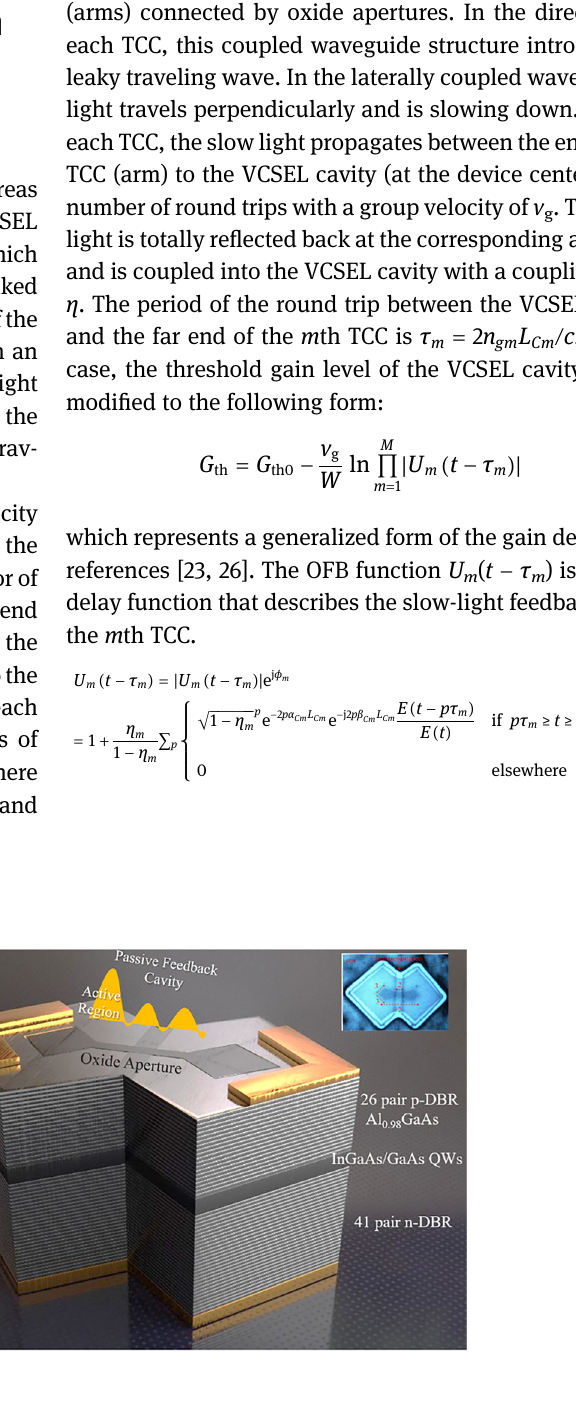
Figure 2: A scheme of slow-light feedback in VCSEL with a cascade of multiple